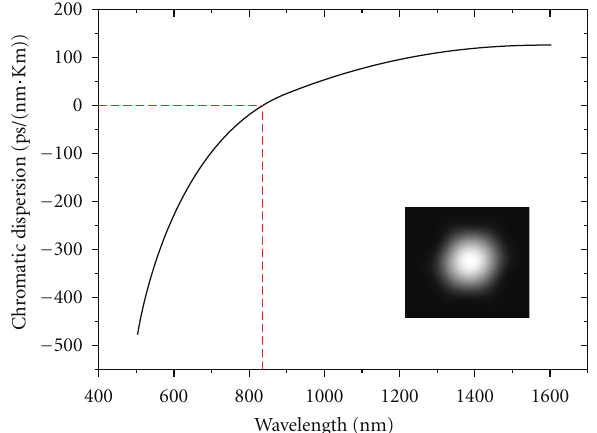
Figure 1: Computed chromatic dispersion of the fundamental mode versus